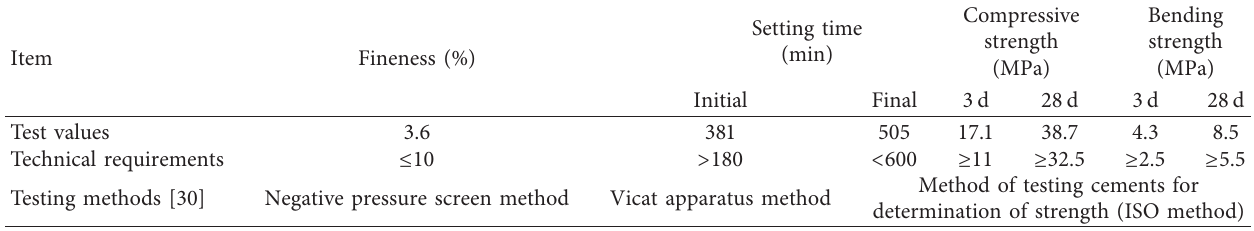
Table 1: Performance index of composite Portland cement.